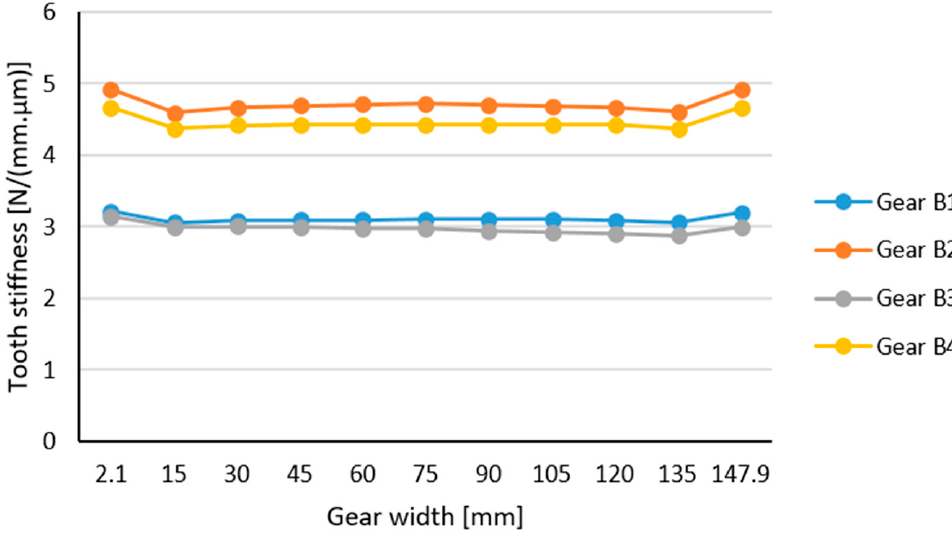
Figure 17. The stiffness along the width of the tooth of the cast gear wheel located above the hole. Figure 18 is a comparison of the effect of weight loss on gear stiffness for cast spur gears. Wheel B4 was chosen as a wheel with zero mass loss, because its weight was the largest of the proposed models. However, the B4 wheel weighed 50.5% less than a full solid- body gear wheel. From Figure 18 it was determined that the gearing stiffness decreased with an increase in material loss. The exception was the B3 wheel due to its shape. Gear wheels B1 and B3 had the highest mass reduction, but their gear stiffnesses were smaller compared to wheels B2 and B4. The wheels B2 and B4 had almost the same amount of gear stiffness, but the wheel B2 had a greater mass reduction, which was more advantageous in terms of weight. Due to its having the highest gear stiffness and a relatively good weight, wheel B2 is the most advantageous.